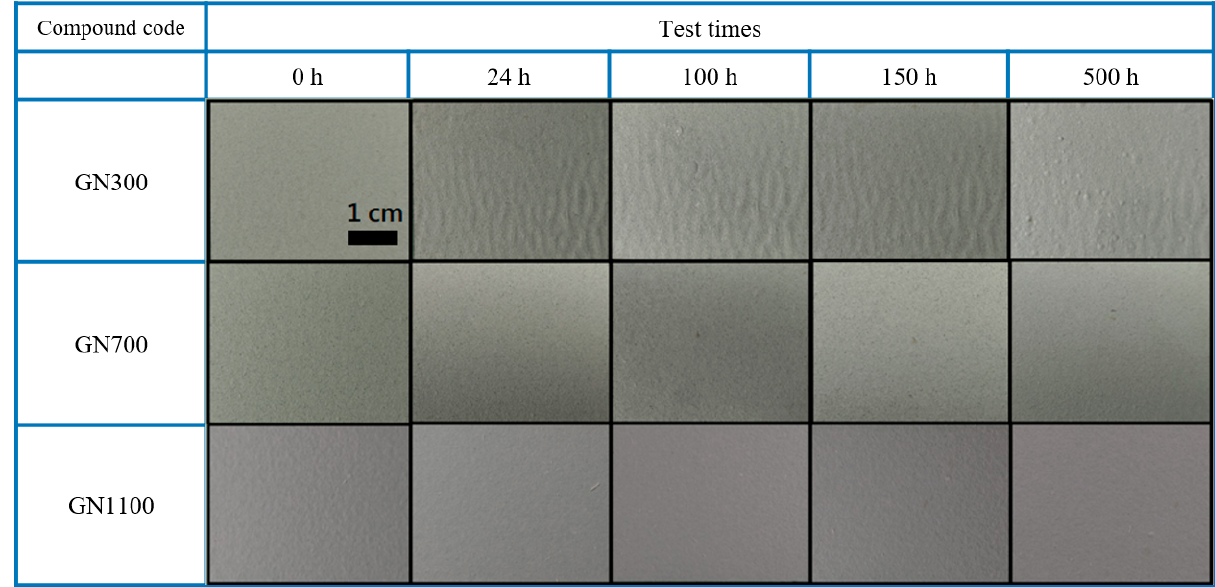
Figure 12. Visual appearances of all samples after various durations (0, 24, 100, 150 and 500 h) of SST.